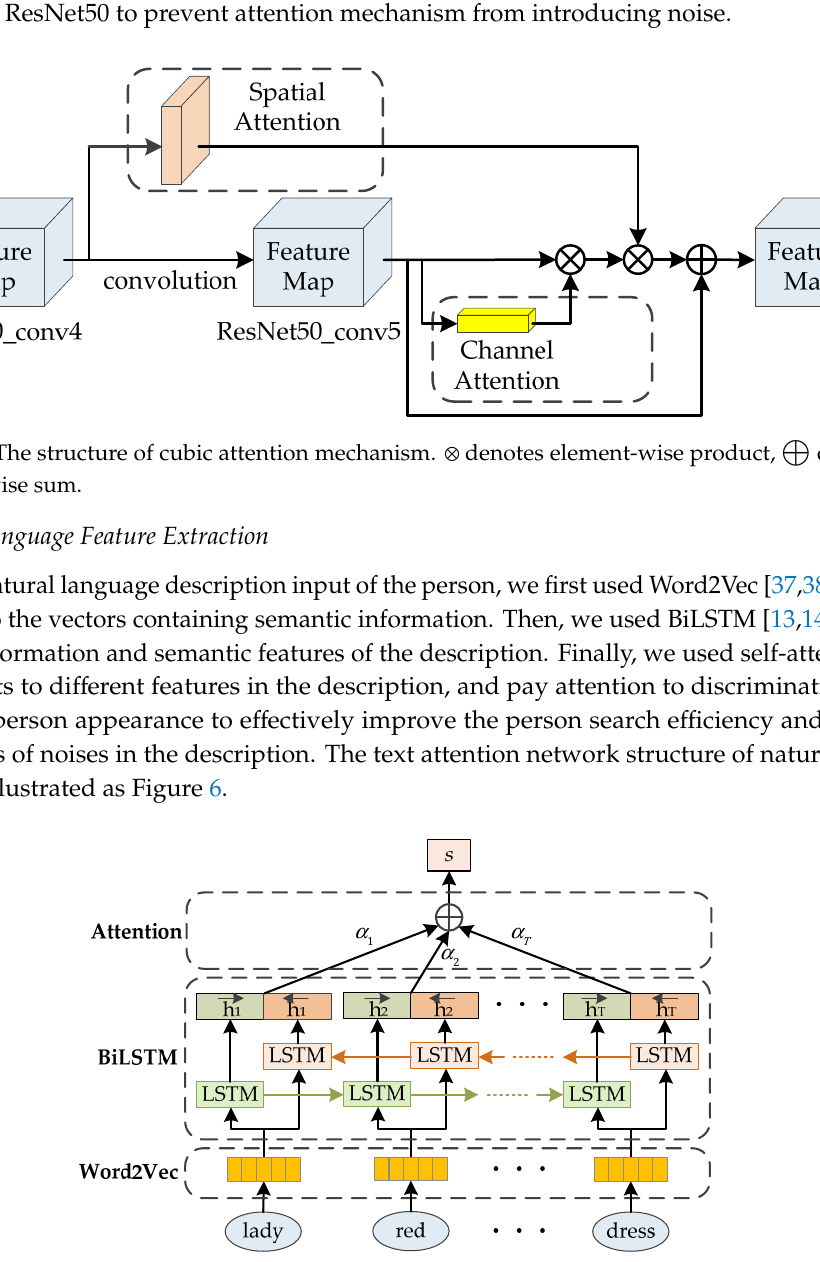
Figure 6. The text attention network structure for nature language feature extraction.